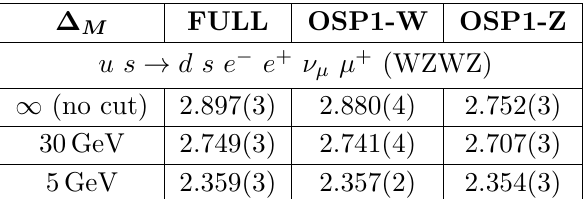
Table 9 . Cross sections ( ab ) for u s are taken into account for the full calculation (FULL), only W ( Z ) resonant diagrams contribute to the approximate calculation with OSP1-W(Z). Selection cuts are: p j 600 GeV ; (cid:1) (cid:17) jj > 3 : 6 ; M 4 ‘ > 300 GeV, M j j